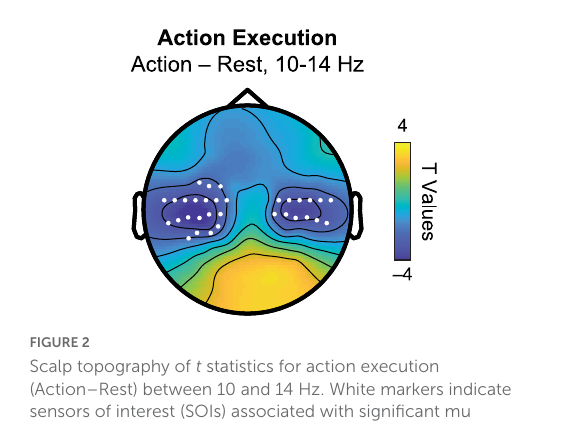
FIGURE2 Scalp topography of t statistics for action